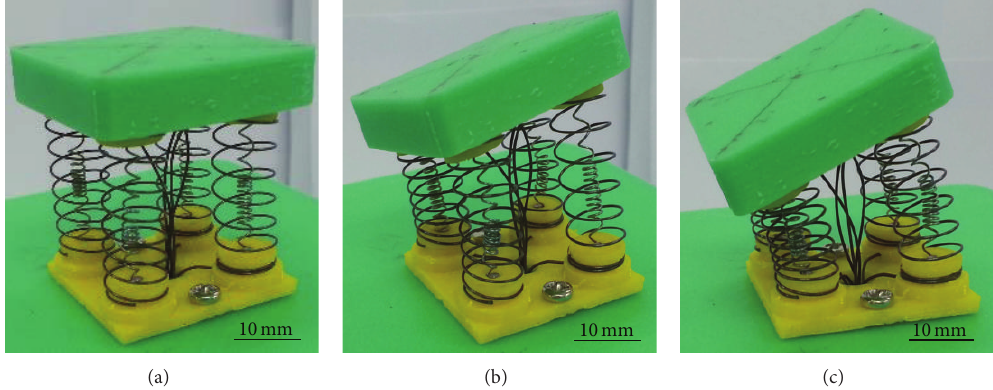
Figure 14: Tilting effect of miniature Stewart platform prototype; (a) initial state; (b) one-limb actuation; (c) two-limb actuation.